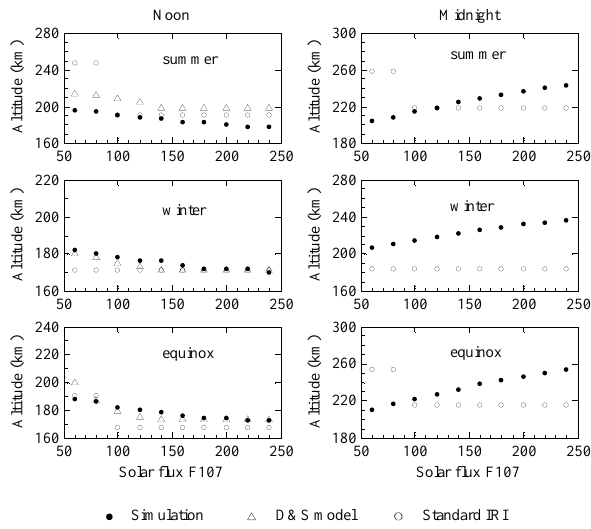
Figure 7. Solar activity variation of LTH at noon (left panels) and midnight (right panels) for various seasons under Ap=10. The detail can be seen in the text.